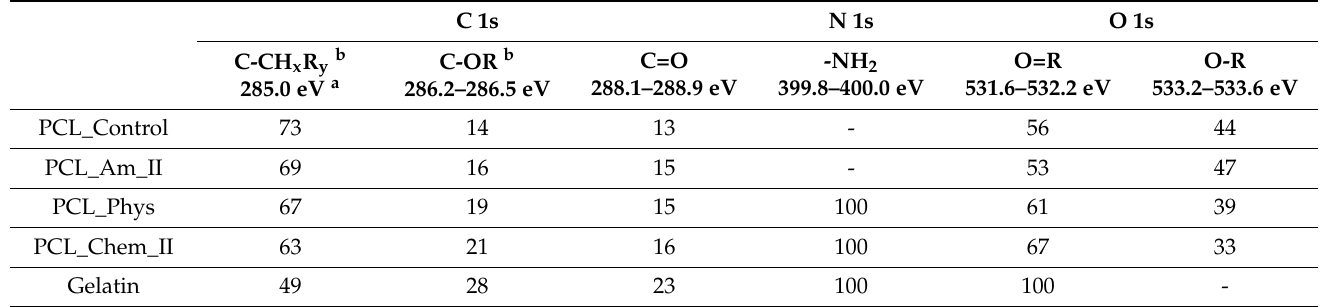
Table 4. Relative concentrations of functional groups for PCL and gelatin